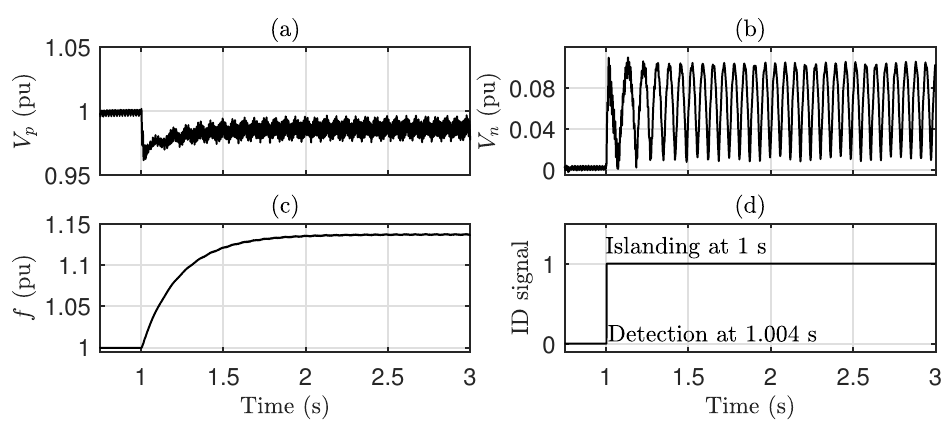
Figure 9. L -type filter case: Performance under load ( L ) imbalance: ( a , b ) estimated magnitudes of positive- and negative-sequence PCC voltage, respectively; ( c ) estimated frequency; and ( d ) ID